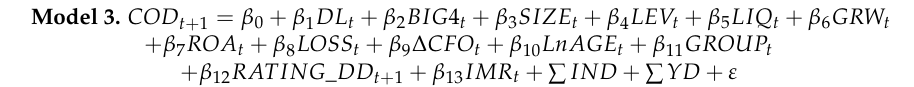
Table 6. Cluster-adjusted ordinary least square (OLS) regression results for